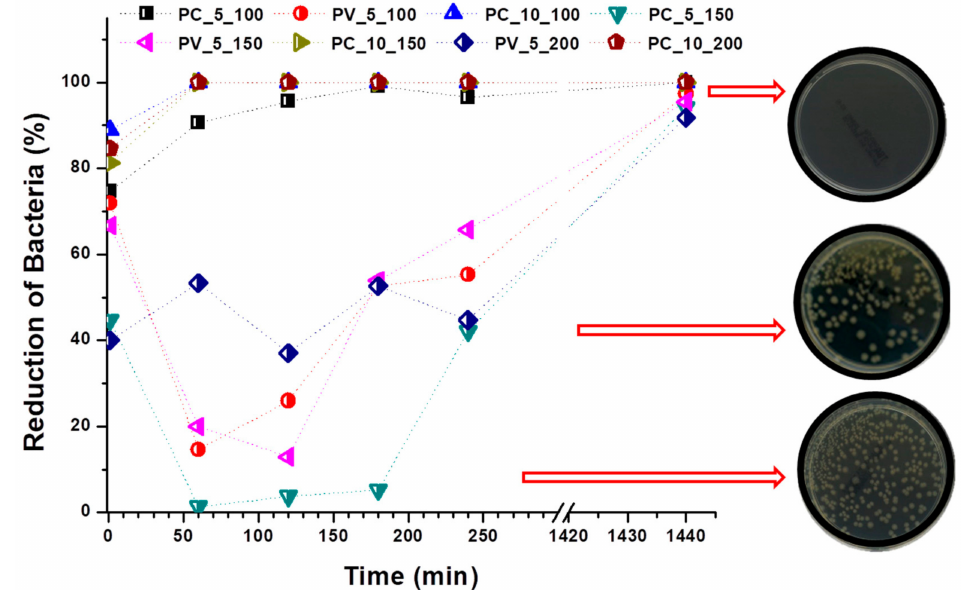
Figure 4. Reduction in bacteria ( Escherichia coli ) over